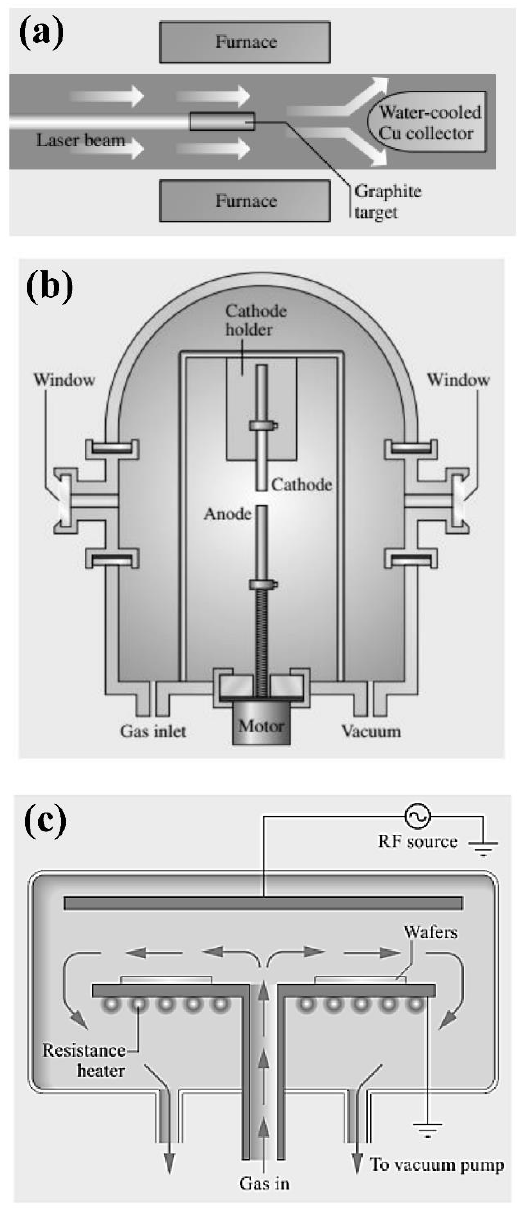
Figure 2. General layout of an ( a ) electrical arch-discharge (adapted by permission from Reference [23]), ( b ) laser ablation (adapted by permission from Reference [23]) and ( c ) chemical vapor deposition apparatus (adapted by permission from Reference [25]) used to synthesize multi-walled carbon nanotubes.